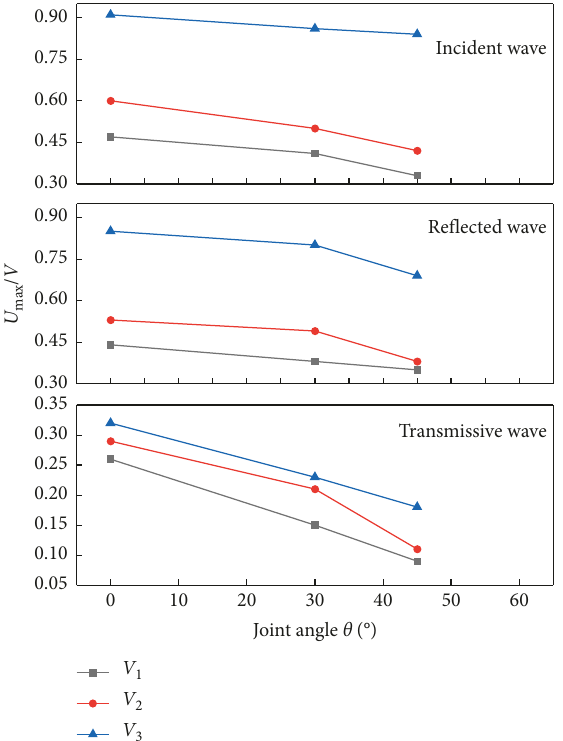
Figure 6: The variation of U joint